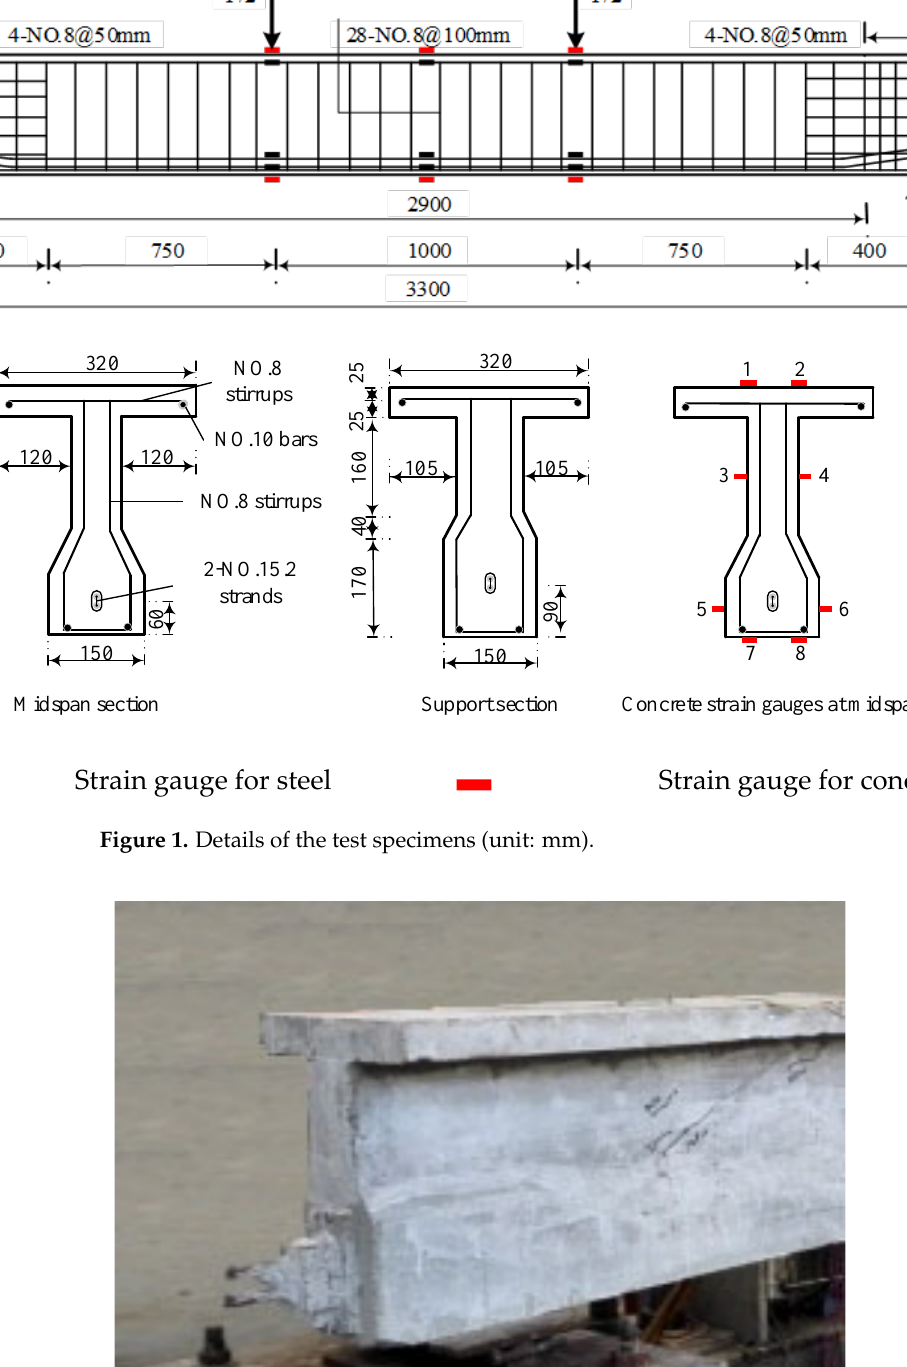
Figure 2. Anchor end of the model beam. Table 1. Mixture ratio and type of concrete.